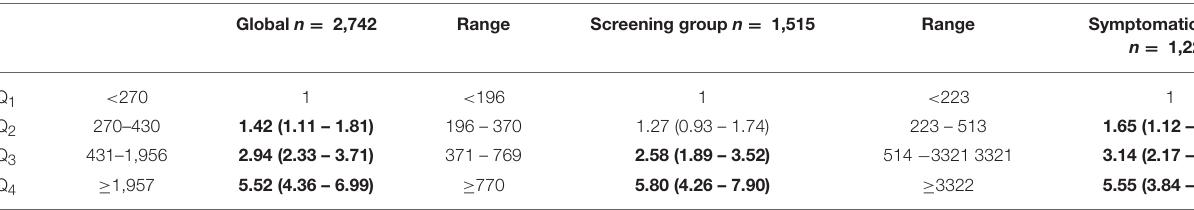
TABLE 4A | Risk of advanced neoplasia (advanced adenoma + cancer) according to Hb quartil.